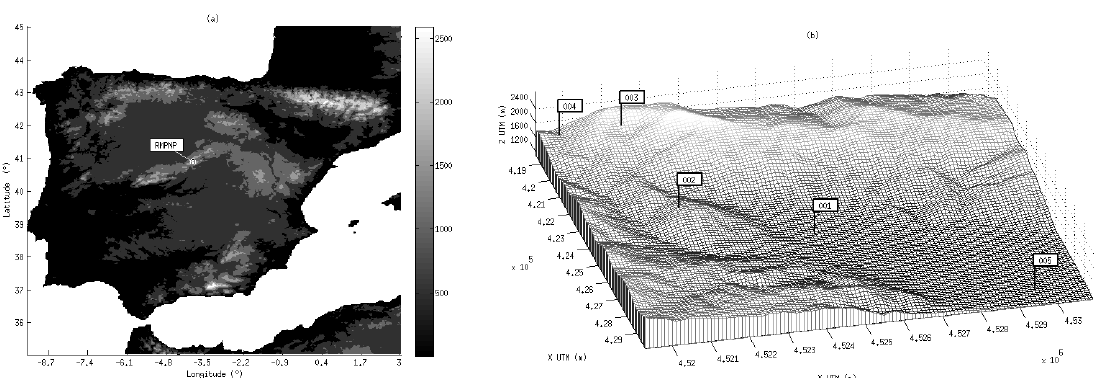
Figure 1. ( a ) Location of the Peñalara Natural Park Meteorological Network in Sierra de Guadarrama; ( b ) Location of the automatic monitoring